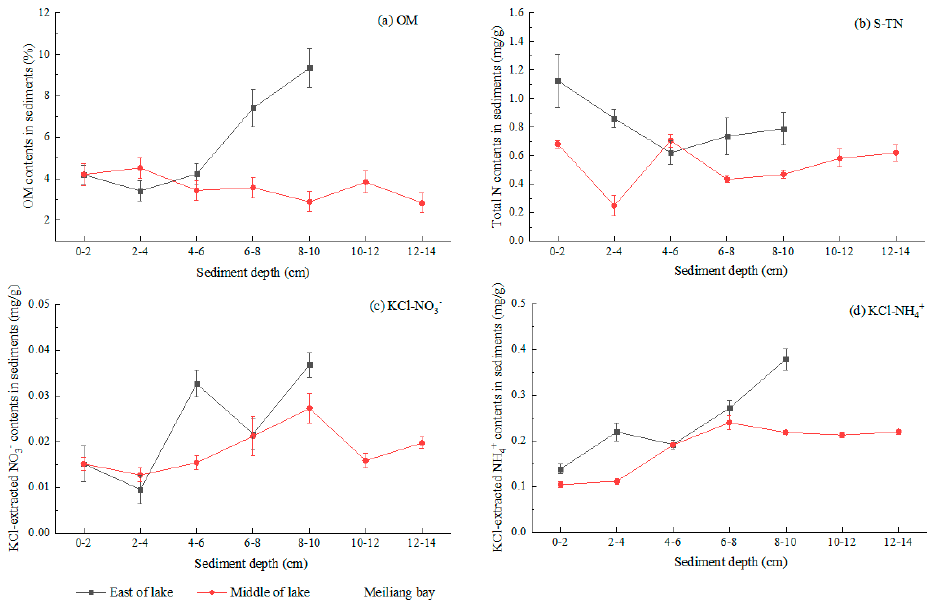
Figure 5. N species in the sediment layers of Taihu Lake.